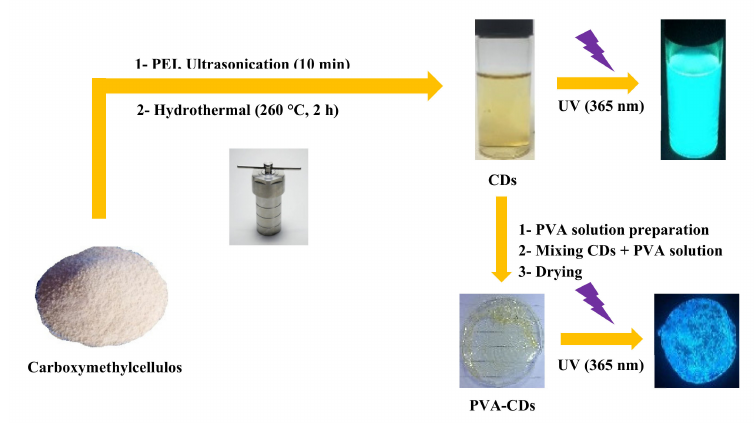
Figure 1. Schematic representation of the preparation of CDs and PVA-CDs film from CMC waste.